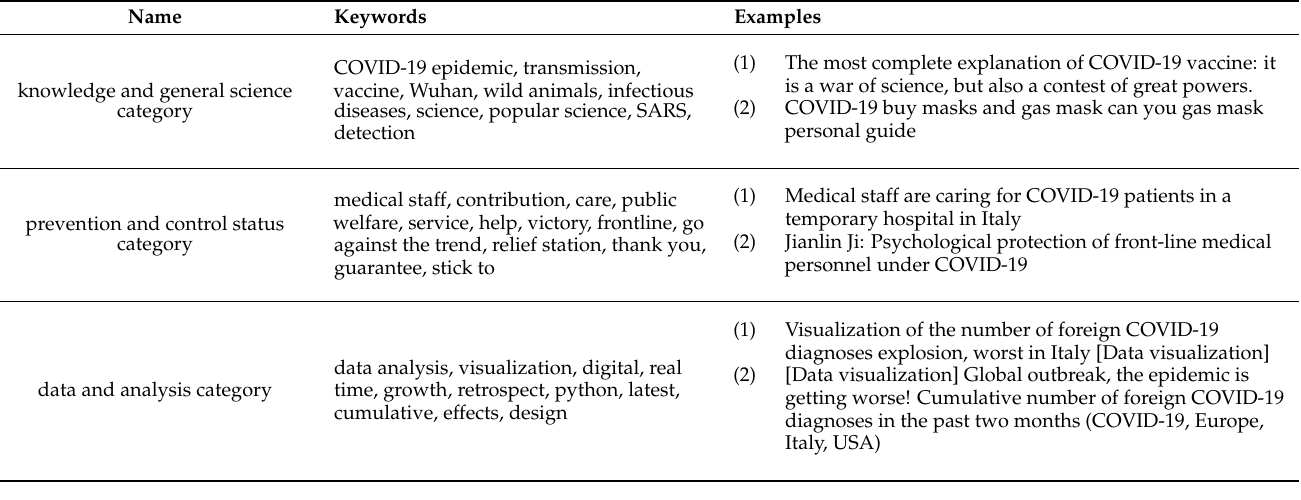
Table 2. Content type of COVID-19 video.